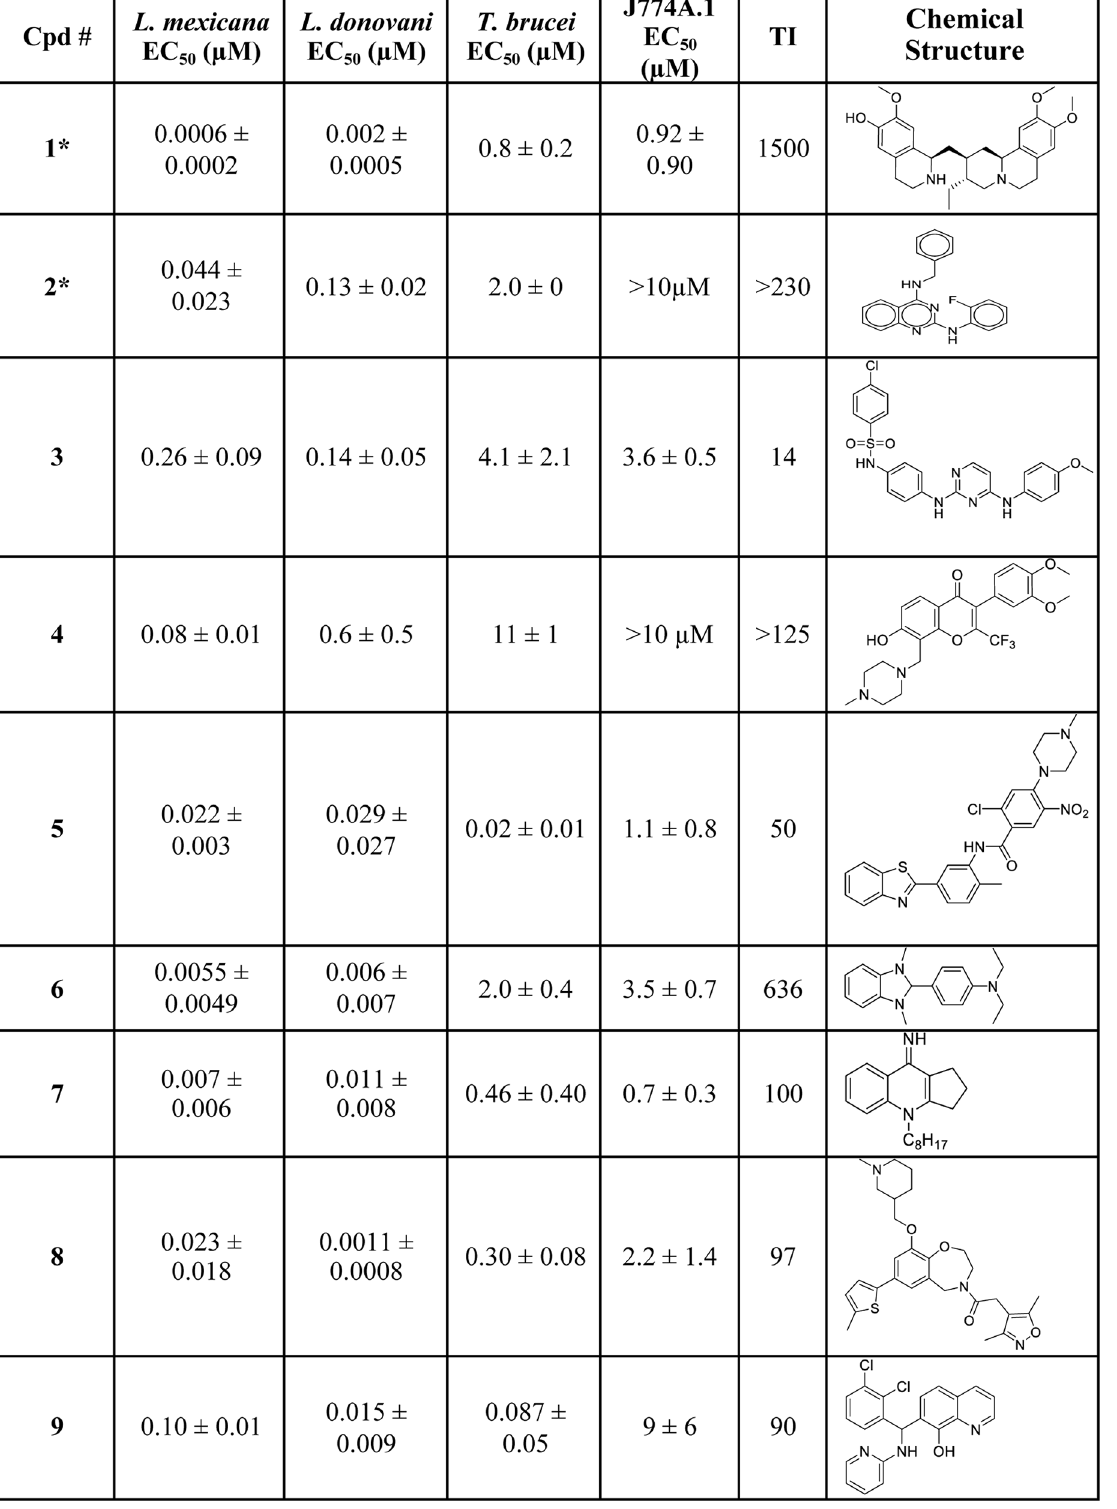
PLOS NeglectedTropical Diseases | https://doi.org/10.1371/journal.pntd.0006157 December29,